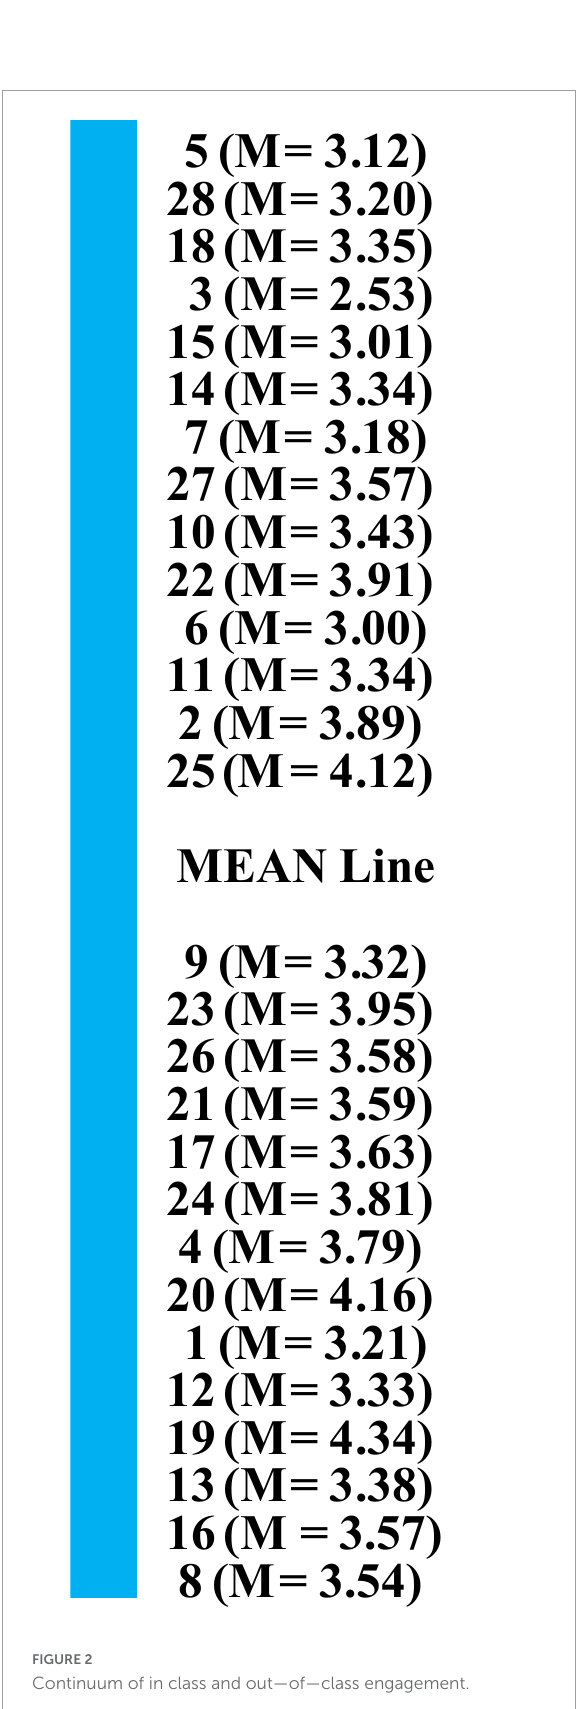
FIGURE2 Continuum of in class and out—of—class